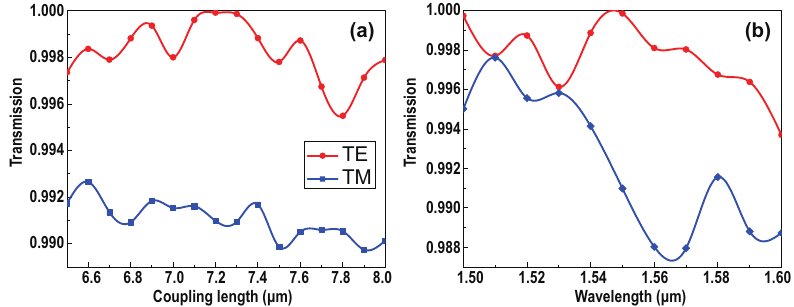
Figure 4. The transmission of the output taper versus ( a ) MMI length and ( b ) wavelength. TE polarization: red circle; TM polarization: blue